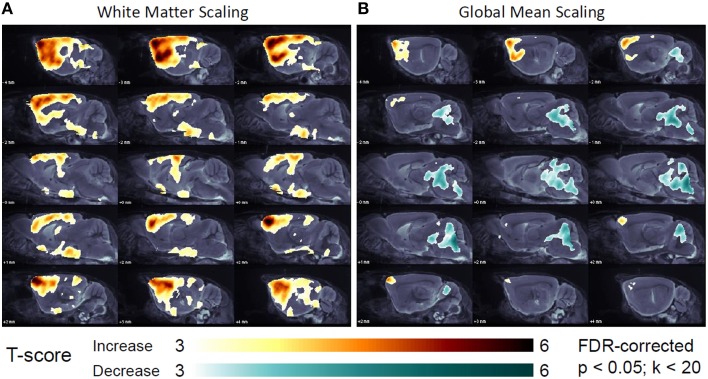
Longitudinal changes in regional [18F]-florbetaben uptake in the short-term 6 week follow-up, study of (N = 37) PS2APP mice after intensity scaling to the hindbrain white matter (A) and the global mean uptake (B) as assessed by SPM (FDR-corrected; p < 0.05; k < 20). T-contrasts expressing significant longitudinal increases (yellow-red) and decreases (turquois-green) are projected upon sagittal slices of the MRI mouse brain atlas.